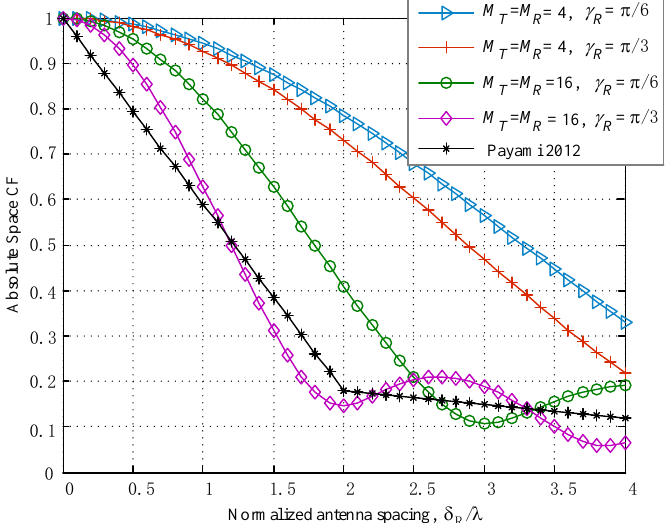
Figure 4. Proposed time-variant space CFs for the NLoS paths, with respect to numbers of the transmitter/receiver antennas and different antenna angles γ R , when t = 0 s, N = 4, R = 6 m, γ T = 2 π /3, v R = 54 km/h, and φ v = 0